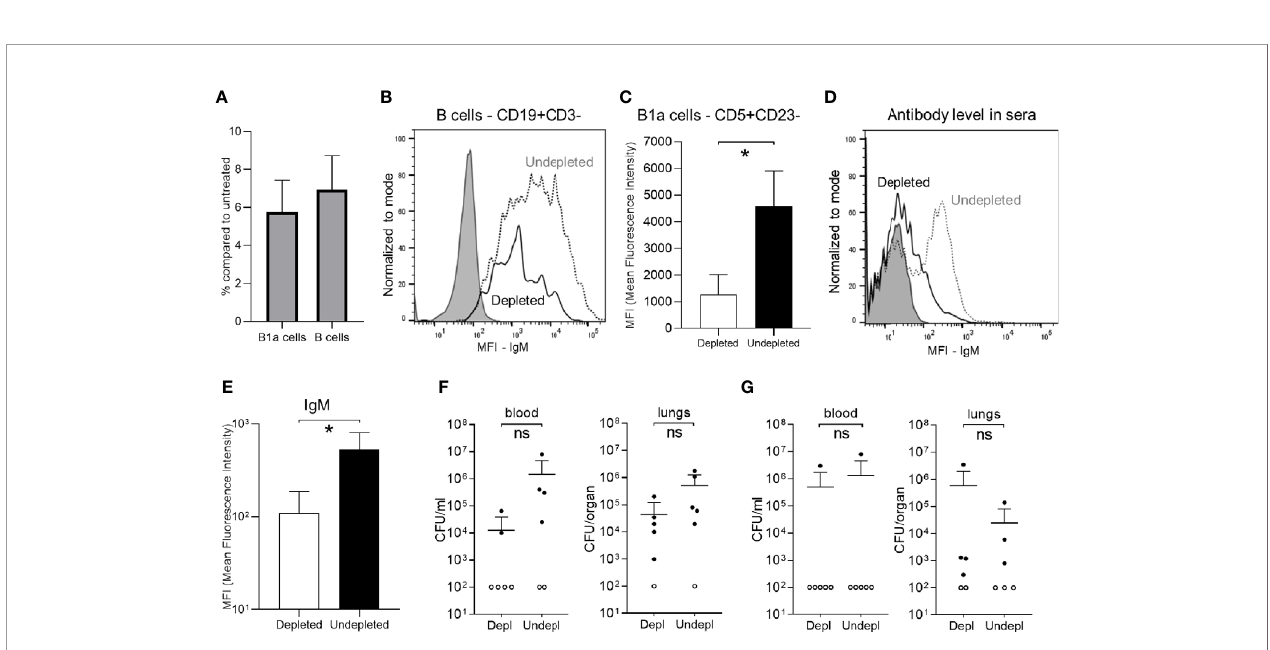
FIGURE 3 | Effect of B cell depletion on natural IgM mediated immunity against S. pneumoniae. Flow cytometry analysis of splenocytes recovered from C57B/6 mice 7 days after IP administration of 100ug of aCD20 antibody (six mice/group). (A) Percentage of persisting natural IgM secreting cells (B1a, CD5+CD23-) and total B cells (CD19+CD3-) compared to undepleted controls. (B) A representative fl ow cytometry plot of the relative level of IgM expression in splenic B cells from aCD20 treated (solid line) and untreated controls (dotted line). Unstained sample data are also shown (gray fi lling). (C) IgM expression level (Mean fl uorescence intensity - MFI) on B1a cells (CD5+CD23-) in the depleted (white bar) versus undepleted mice (black bar). (D) A representative fl ow cytometry plot of IgM binding to S. pneumoniae 6B strain incubated in serum from undepleted (dotted line) and B cell depleted (solid line) mice; unstained samples (gray fi lling). (E) Mean MFI of IgM binding to S. pneumoniae 6B strain in serum from B cell depleted (white column) or undepleted (black columns) C57B/6 mice. (F, G) Effects of B cell depletion of immune naïve C57B/6 mice on susceptibility to S. pneumoniae pneumonia. Mice were inoculated intranasally with 2 x 10 6 CFU S. pneumoniae 6B (F) and D39 strain (G) CFU in 50 ul PBS under deep anaesthesia and CFU were measured at 24 h by plating serial dilutions of blood and lungs. For all graphs, bars represent the mean values for each group, error bars indicate standard deviations and Mann Whitney U test was used for statistical analysis (*P < 0.05, ns, not signi fi